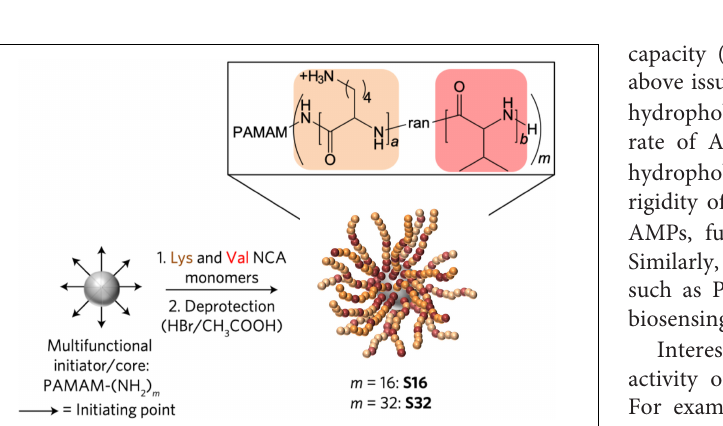
FIGURE 5 | Illustration of the polymer–peptide conjugates and the principle of gelatinase-induced morphology transformation.